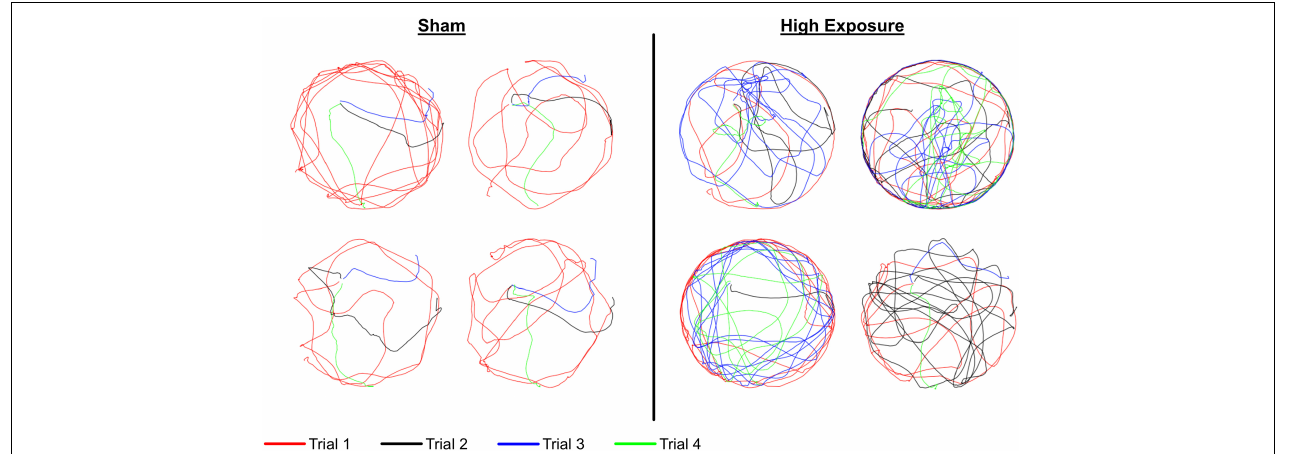
FIGURE 8 | Representative swim paths for day 2 of the MWM protocol for sham (left) and high exposure (right) groups. Each of the four trials are represented and the platform was placed in the northwest (upper left) quadrant of the MWM for all four trials. These figures demonstrate a less effective search strategy for high exposure rats during trial 3 (blue), wherein a majority of sham rats found the platform during their initial pass and most high exposure rats either missed the platform or continued to search around the outside of the maze despite either finding or being shown the location of the hidden platform on two prior trials that day and four trials the previous